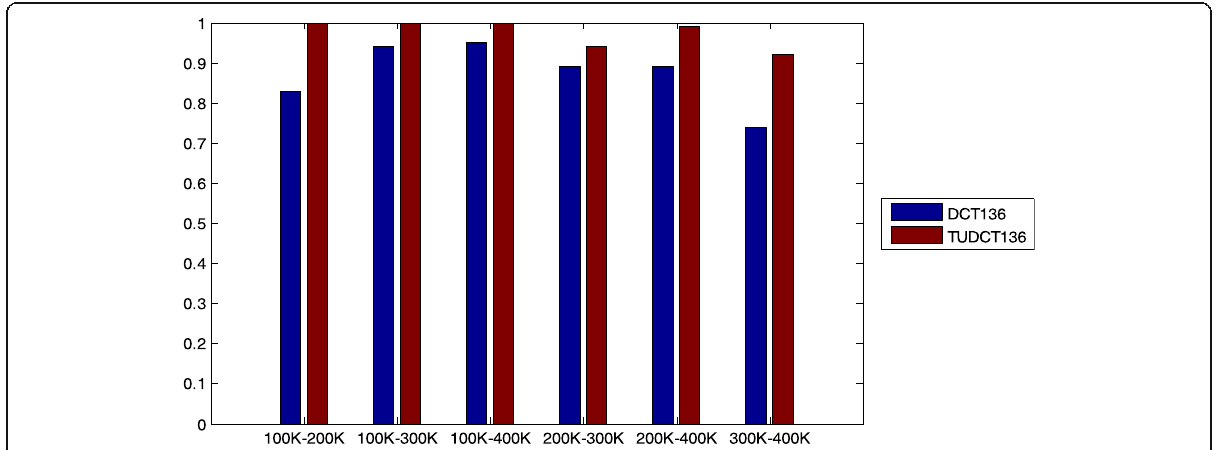
Fig. 10 The mean value (MEAN) of detection accuracy of DCT136 [10] and TUDCT136